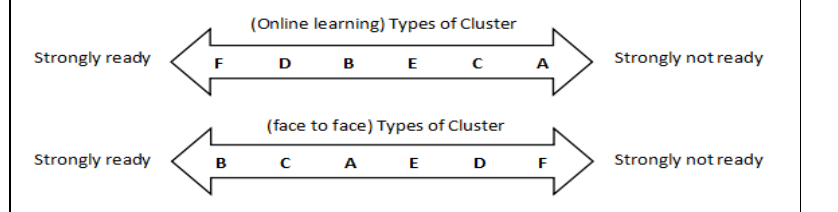
Figure 5. Students’ readiness to follow e-learning and face to face learning systems based on clus- ters.